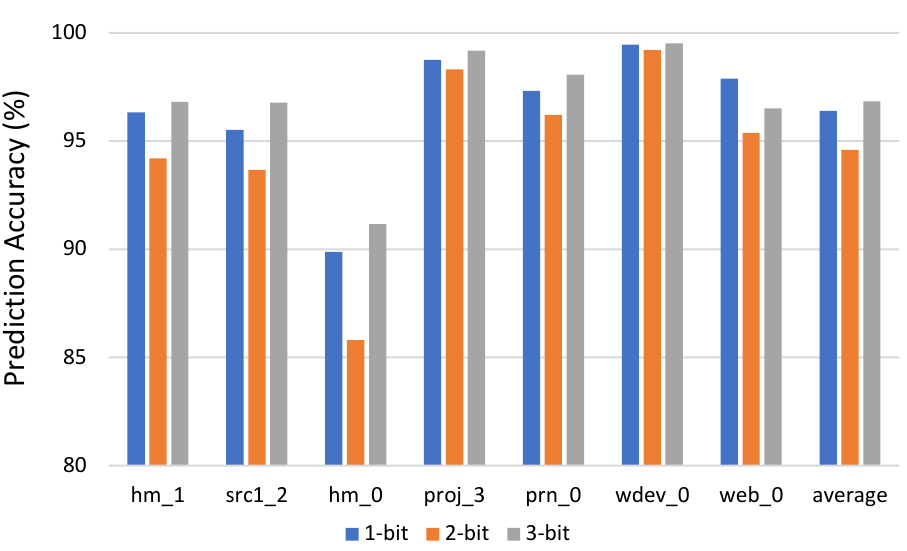
Figure 6. TRH bits count impact on request-type-prediction accuracy.